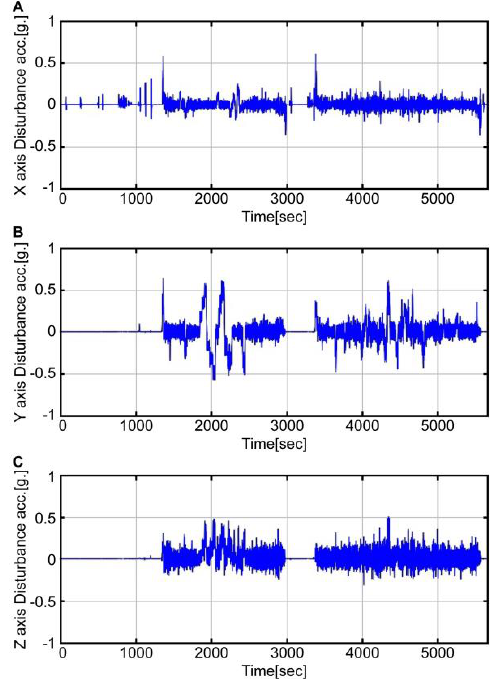
Figure 7. Disturbance acceleration on each axis.